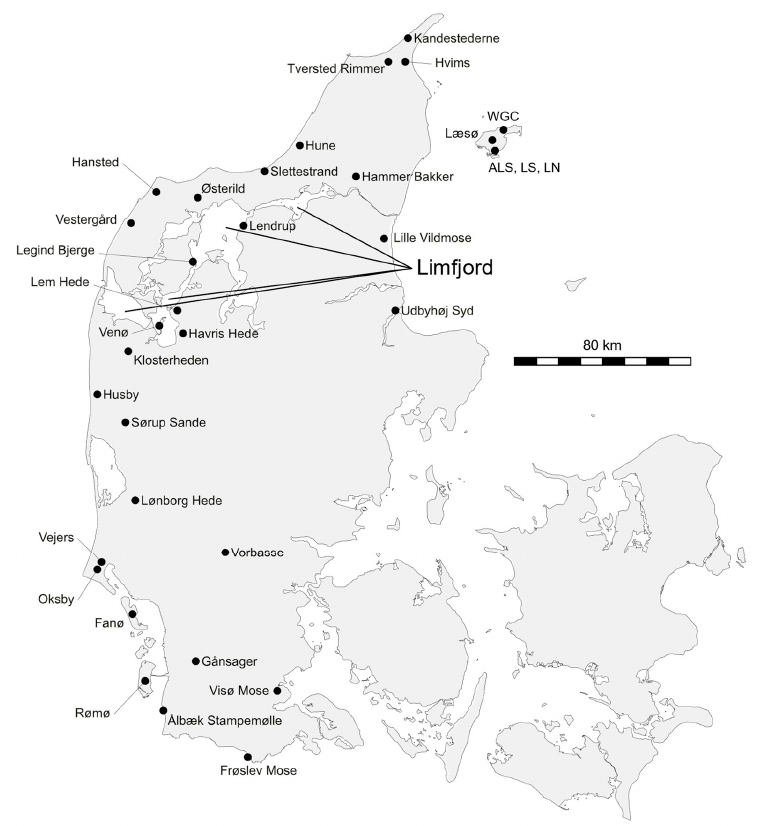
Figure 2. Geographic distribution of sampled localities included in this study. The position of the Limfjord is also marked. Note that the three localities on the southern part of the island of Læsø are within 200 m of each other, so cannot be separated at this resolution. Table 2. Summary of samples, genetic diversity (N A = number of alleles, N E = effective number of alleles, H O = observed heterozygosity, H S = expected heterozygosity), and estimated inbreeding (G IS ) for the combined dataset.